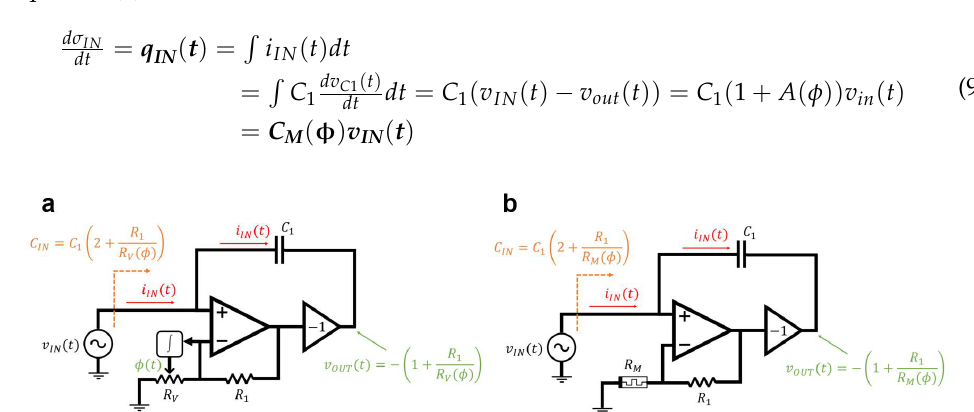
Figure 4. Memcapacitor emulator circuit proposed by Romero et al. [43] implemented with a voltage-controlled resistor ( a ) and with a voltage-controlled memristor ( b ).